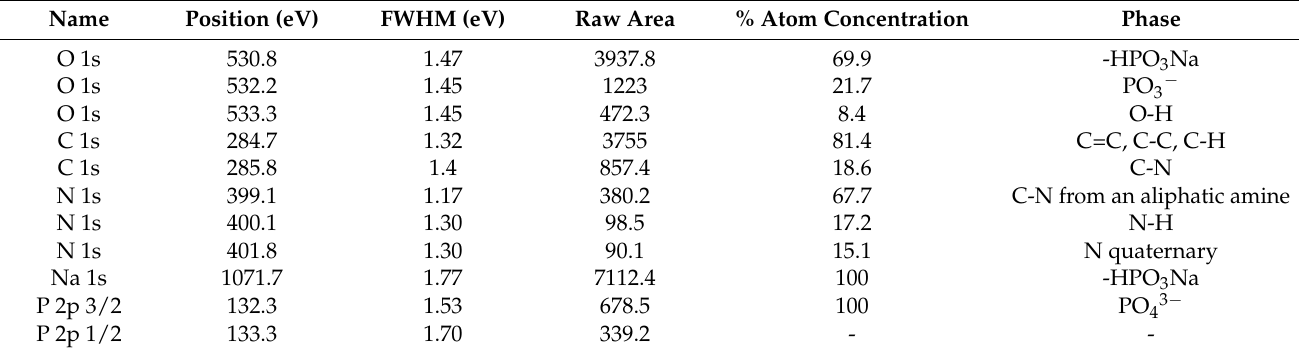
Table 5. The XPS analysis results were obtained in the narrow range of binding energies for Purolite S 950.